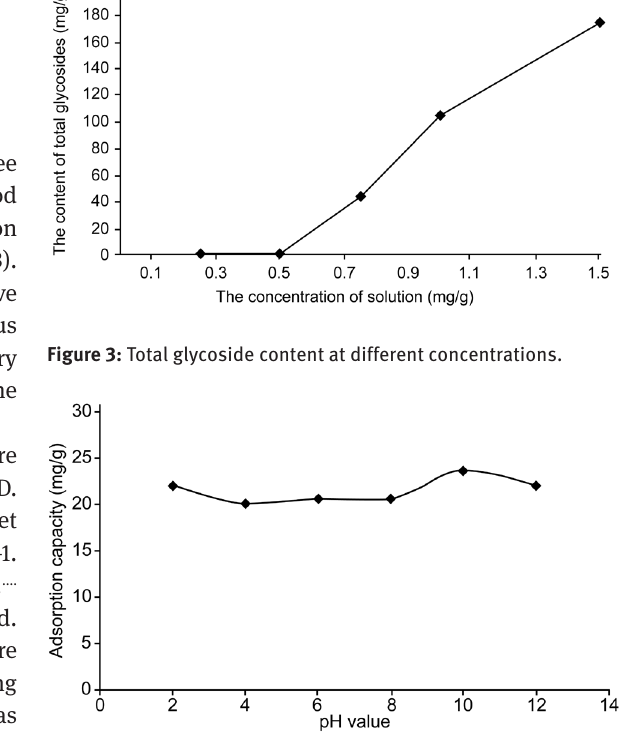
Figure 4: Absorption capacity at different pH